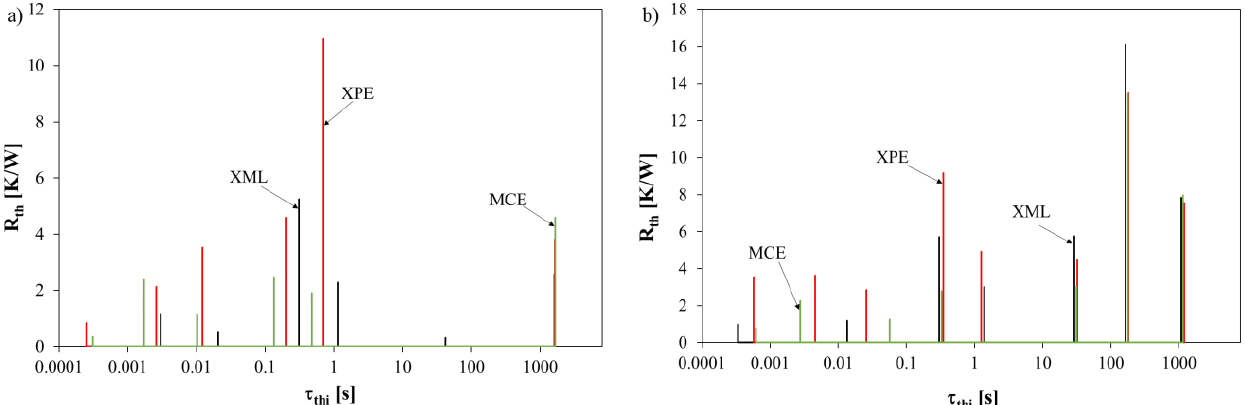
Figure 7. Spectra of thermal time constants of the tested light emitting diodes (LEDs) situated on the heat-sink ( a ) and operating without any heat-sink ( b ) obtained using the ESTYM software and the authors’ set-up.